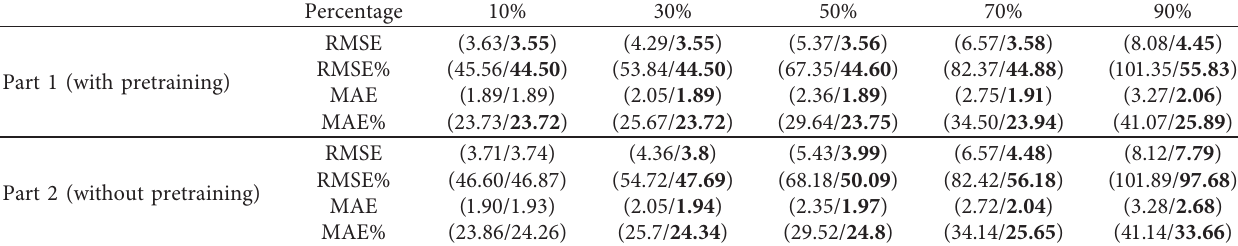
Table 2: Test of bootstrapping algorithm for different percentages of noisy